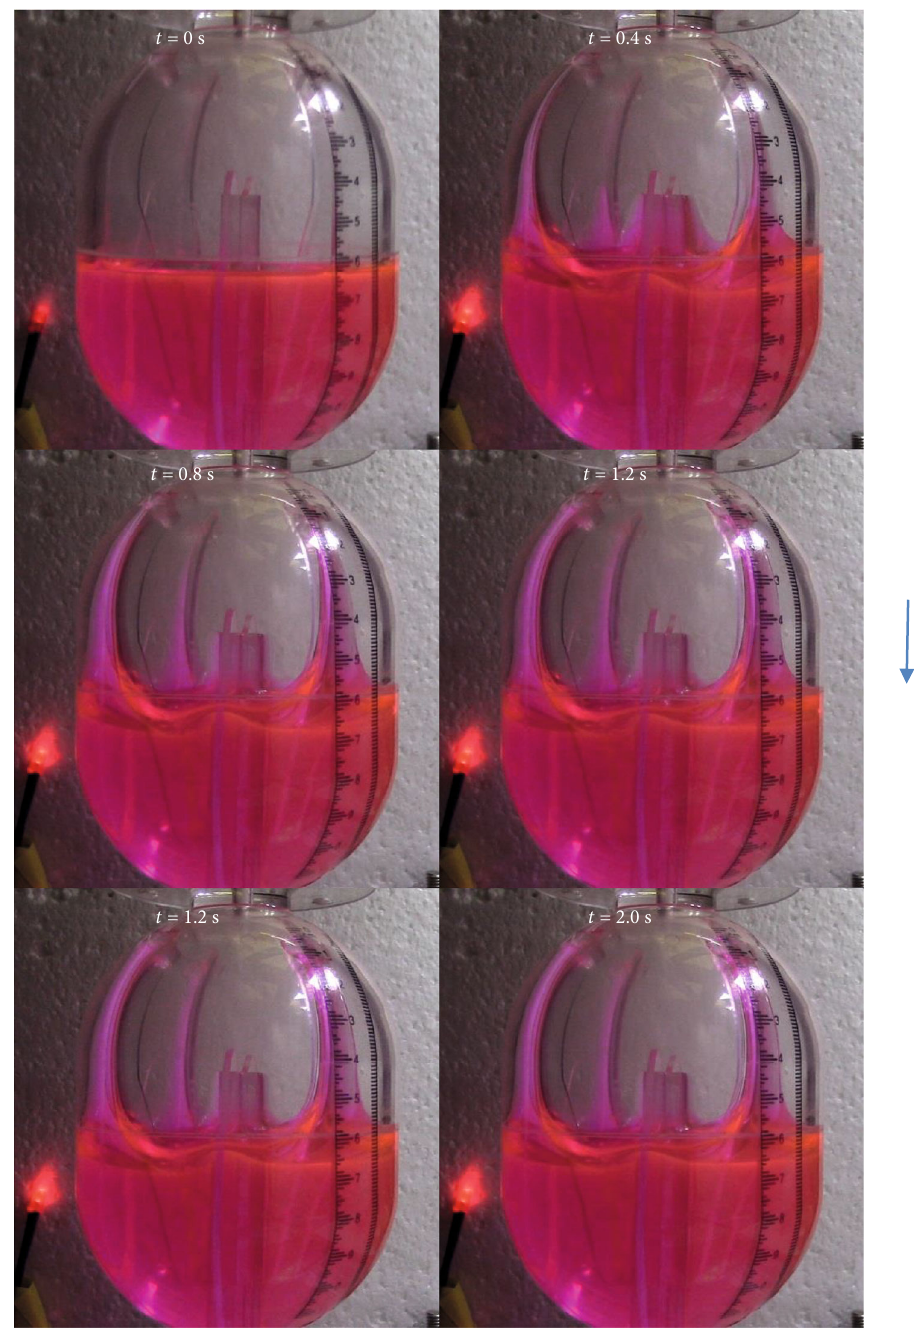
Figure 8: Liquid volume fraction is